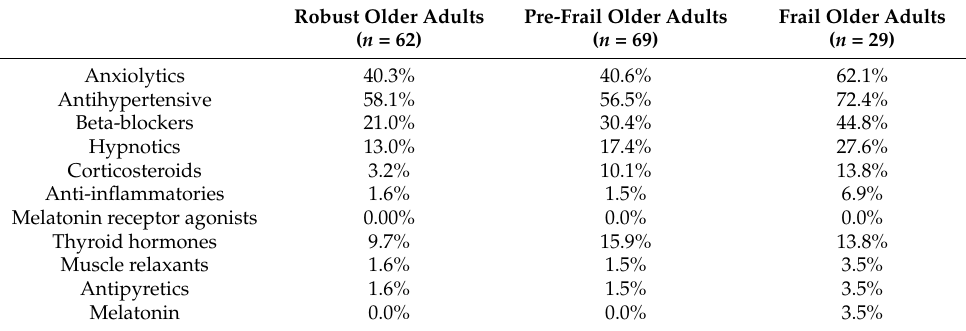
Table 4. Percentage of older adults who, in the past 30 days, took certain types of